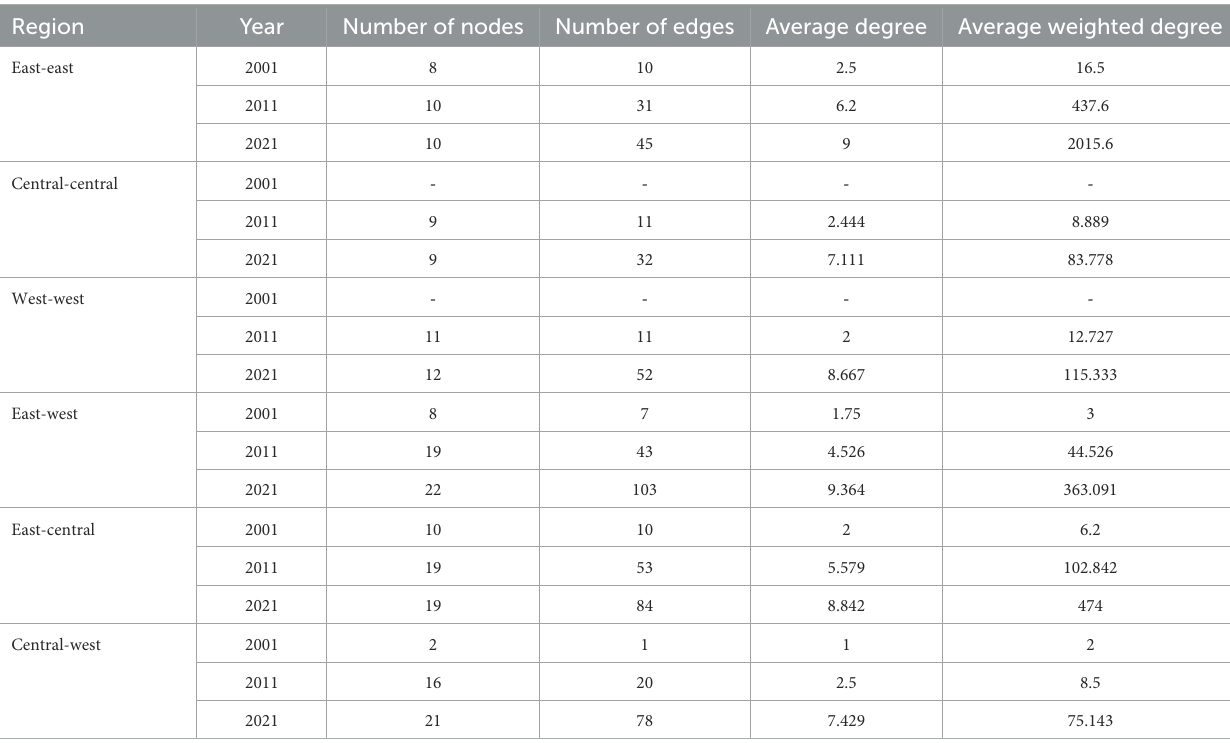
TABLE 9 Statistical characteristics of the interprovincial low-carbon patent cooperation network between the eastern, central, and western regions of China. Region